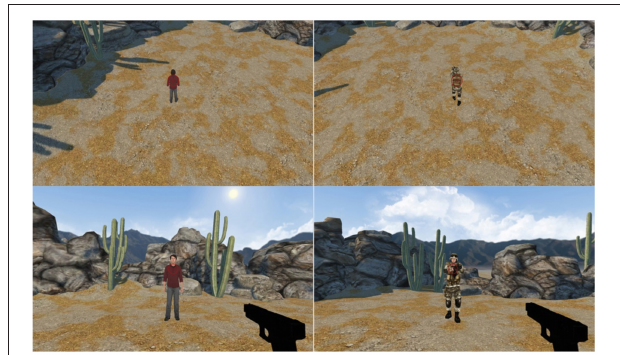
FIGURE 1 | Stimuli. From upper left to lower right: “No-go bird,” “Go bird,” “No-go ego,” “Go ego.” Participants first saw the empty desert environment for 1–2s until a target appeared. Targets appeared with their front/back toward the participant 50% of the time in all conditions.